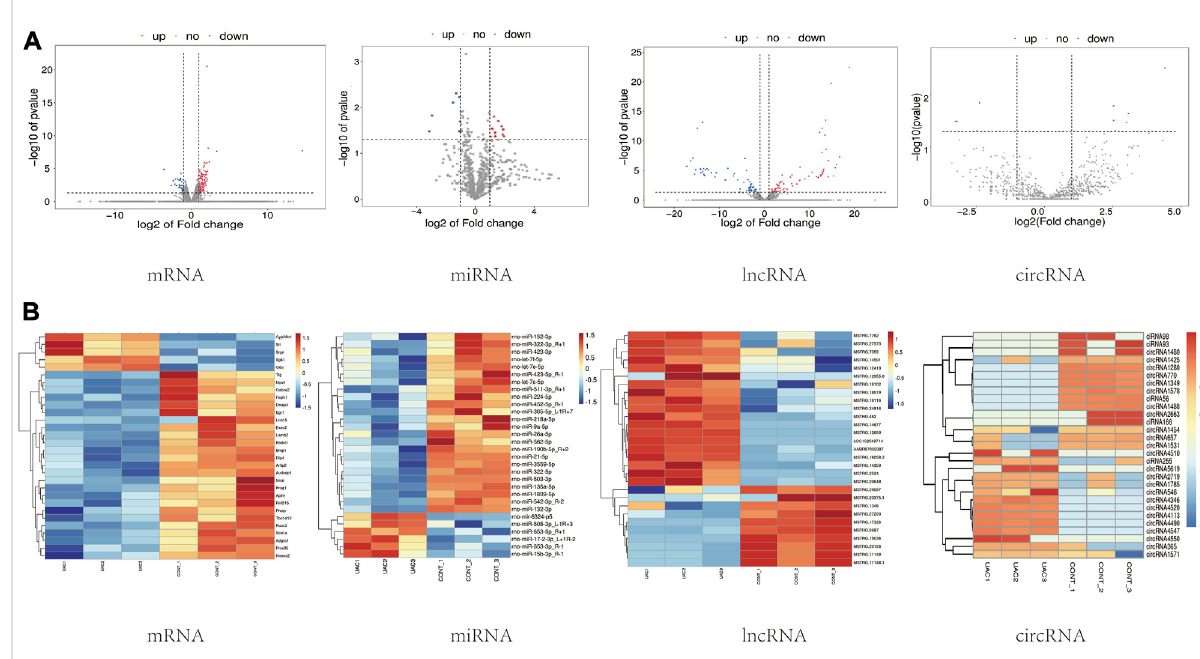
FIGURE 2 (A) Visual statistical results of differential gene analysis. Volcano plots of mRNA, miRNA, lncRNA, circRNA expression. Each dot in the graph represents a speci fi c gene or transcript; the red dots represent signi fi cantly upregulated genes; the blue dots represent signi fi cantly downregulated genes, and the gray dots represent genes without signi fi cantly different expression. (B) Cluster analysis (heatmaps). Red and blue indicate up- and downregulation, respectively. “ CONT ” represents healthy controls, and “ UAC ” represents the temporomandibular joint osteoarthritis